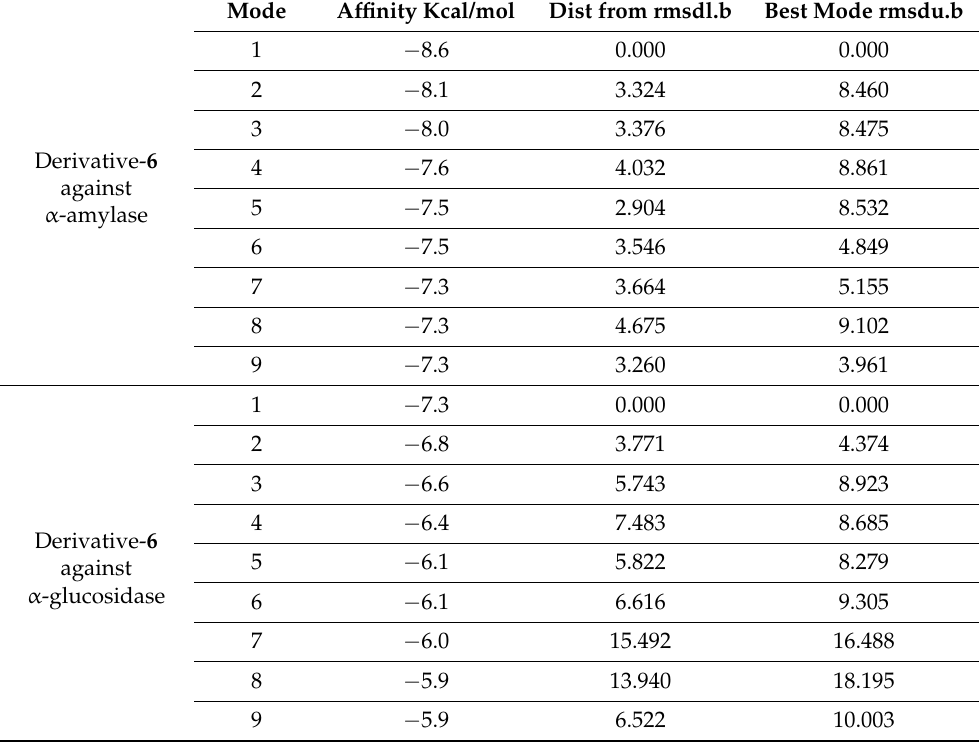
Table 4. The binding affinity and RMSD value of derivative- 6 against α -amylase and α -glucosidase.